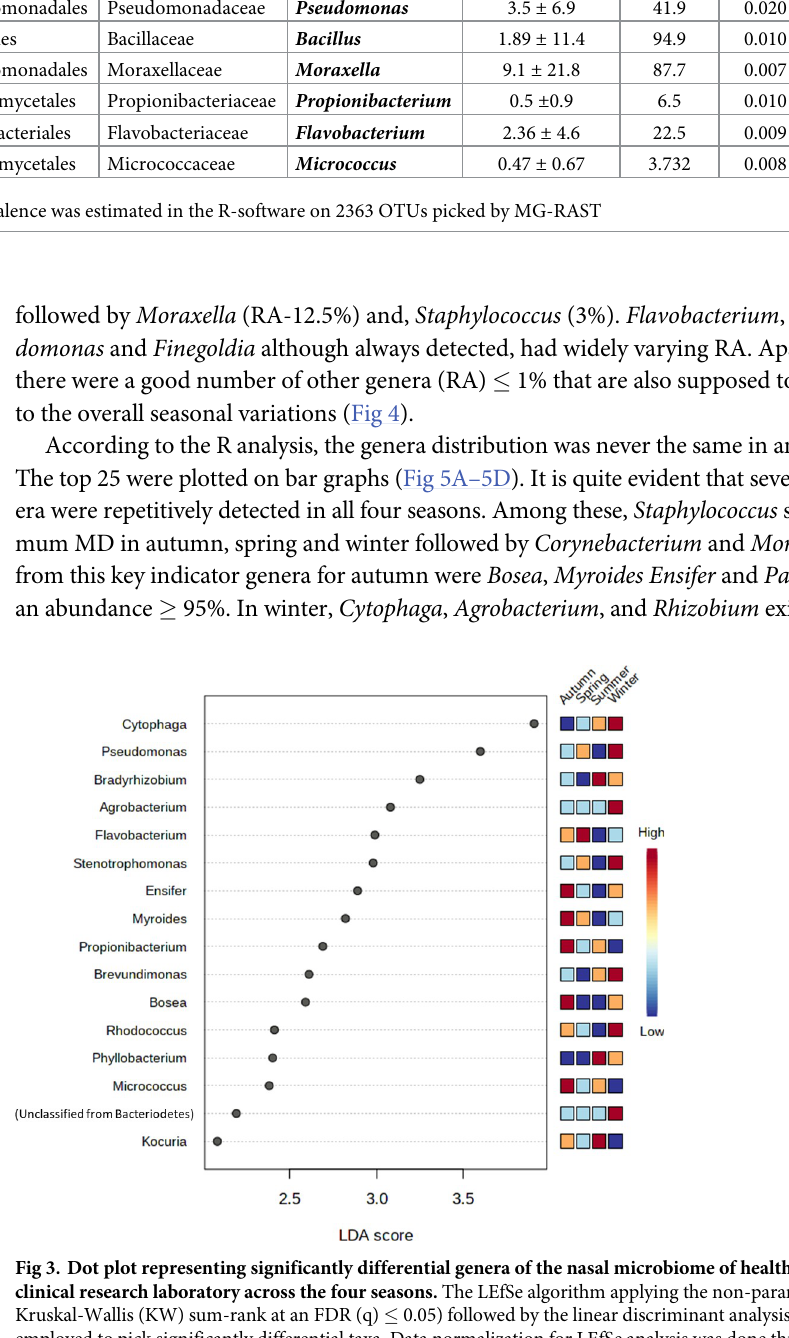
Fig 3. Dot plot representing significantly differential genera of the nasal microbiome of health care workers of a clinical research laboratory across the four seasons. The LEfSe algorithm applying the non-parametric factorial Kruskal-Wallis (KW) sum-rank at an FDR (q) � 0.05) followed by the linear discriminant analysis (LDA) was employed to pick significantly differential taxa. Data normalization for LEfSe analysis was done through relative log expression (RLE). The heat map on the right side of the figure explains the abundance of the genus in autumn, summer, winter and spring seasons. The three colors viz . Blue -Beige and Red represent Low, medium, and high abundance,